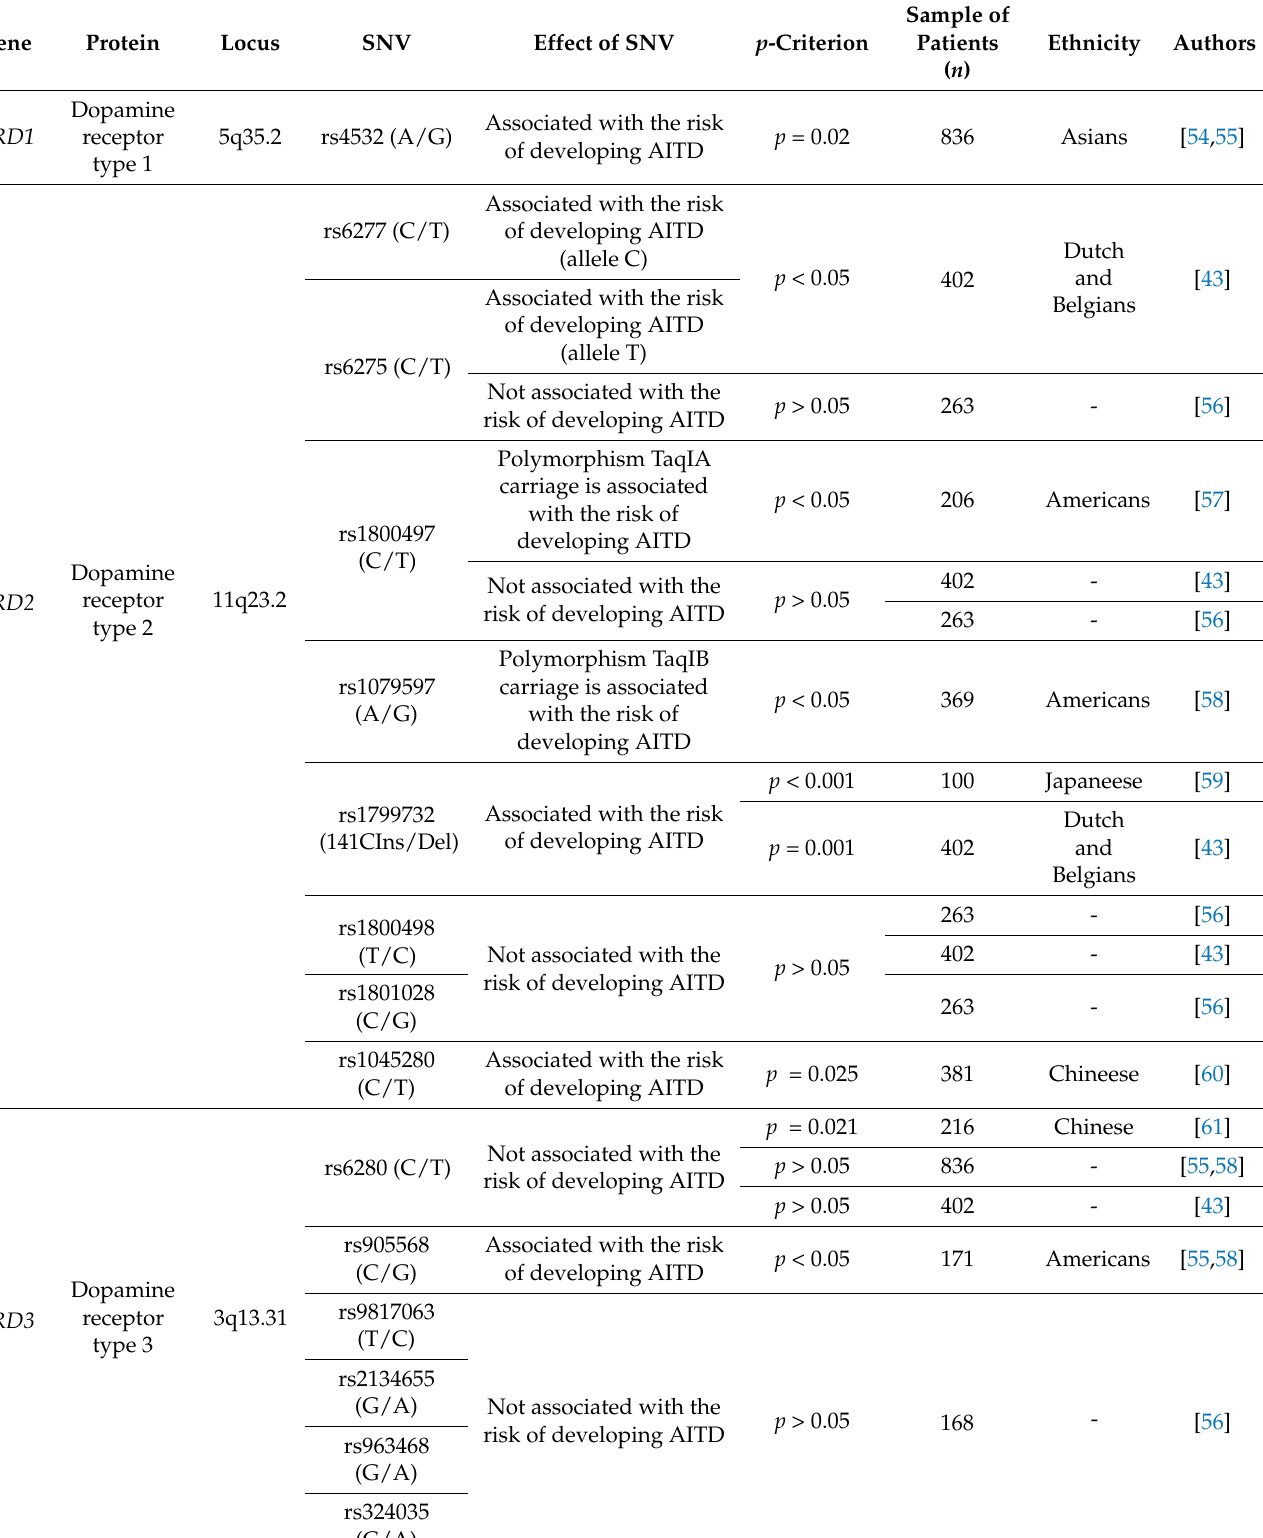
Table 4. Candidate genes encoding dopamine receptors and predisposed to development of antipsychotic-induced tardive